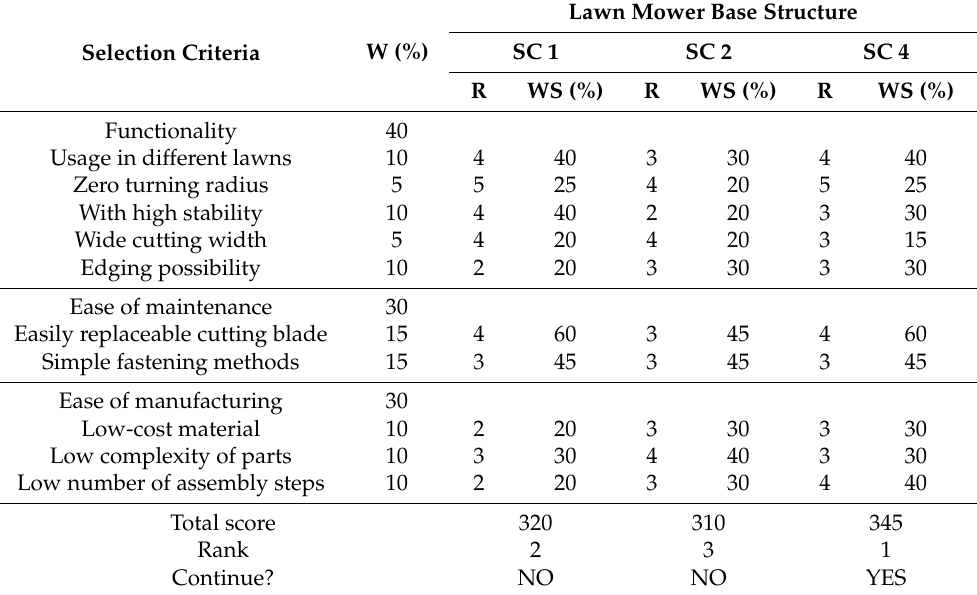
Table 5. Scoring of basic structural concepts.